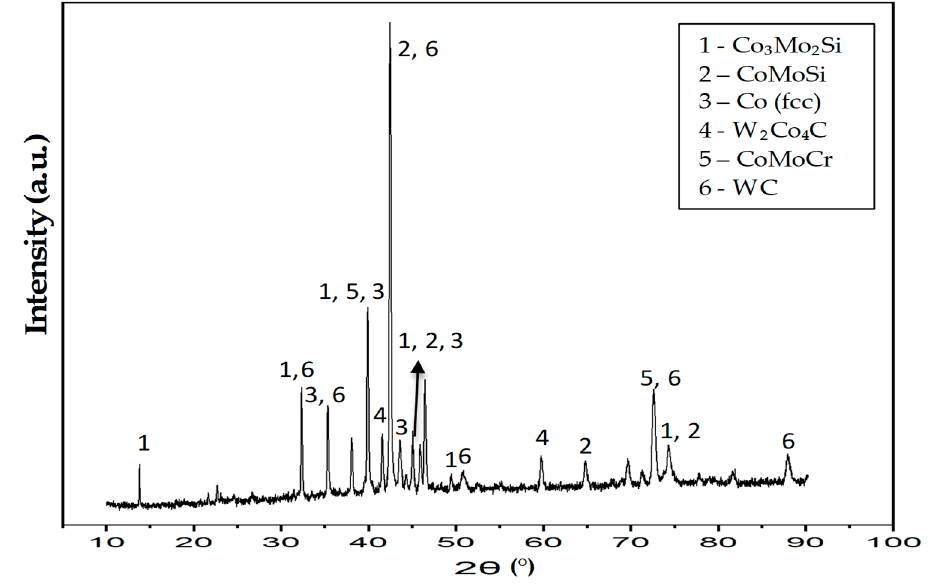
Figure 3. XRD pattern for the T-800/WC coating before oxidation.